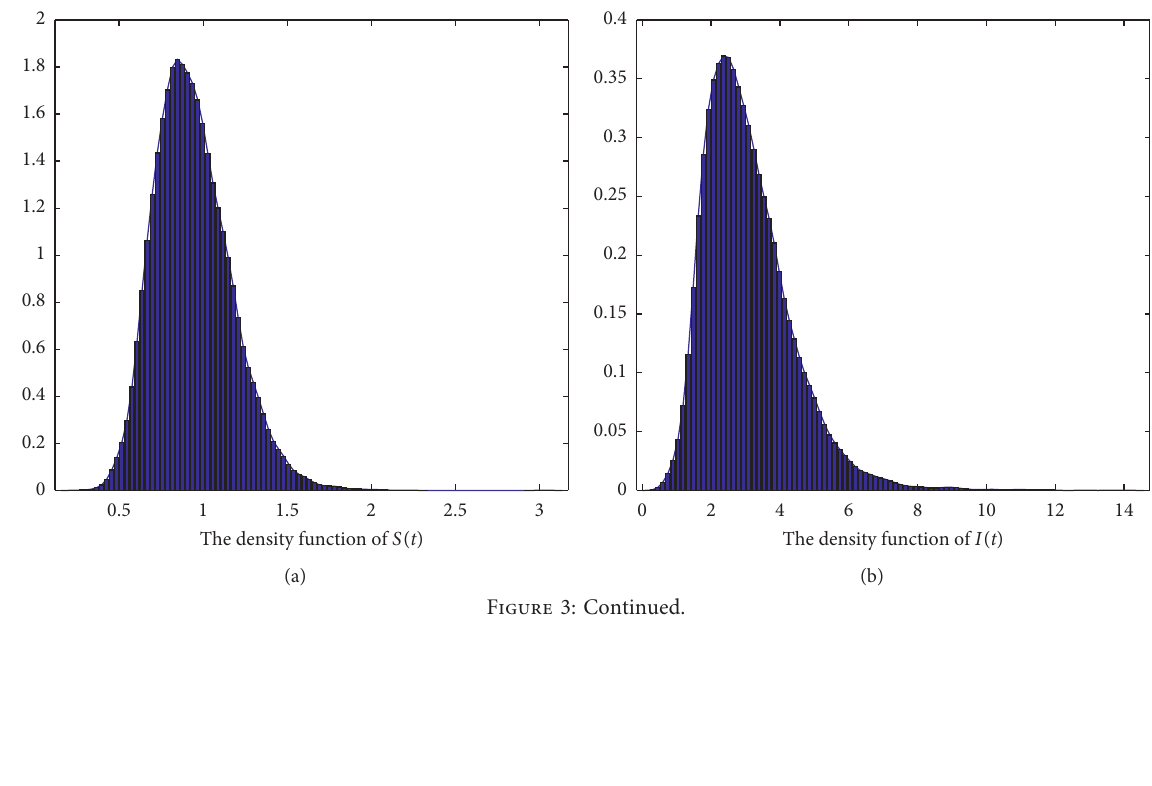
� 0 . 2 , σ � 0 . 2 , and σ � 0 . 3. 1 2 3